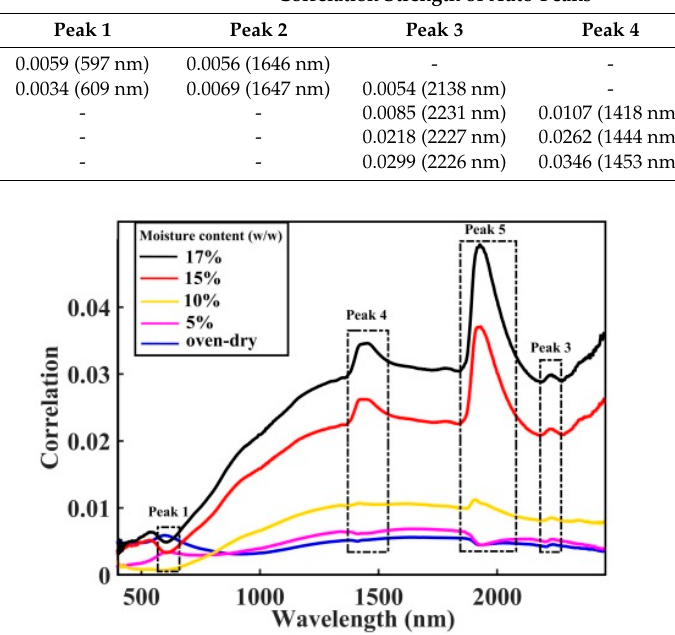
Figure 8. Plots the correlation strength along the diagonal lines of the 2D-COS in Figure 7 as function of the spectral wavelength, when the SOM content is treated as the perturbation variable in each set of the five different moisture content data. This correlation plot shows that the three bands at 597 nm, 1646 nm and 2138 nm are closely related to the SOM characteristic features.